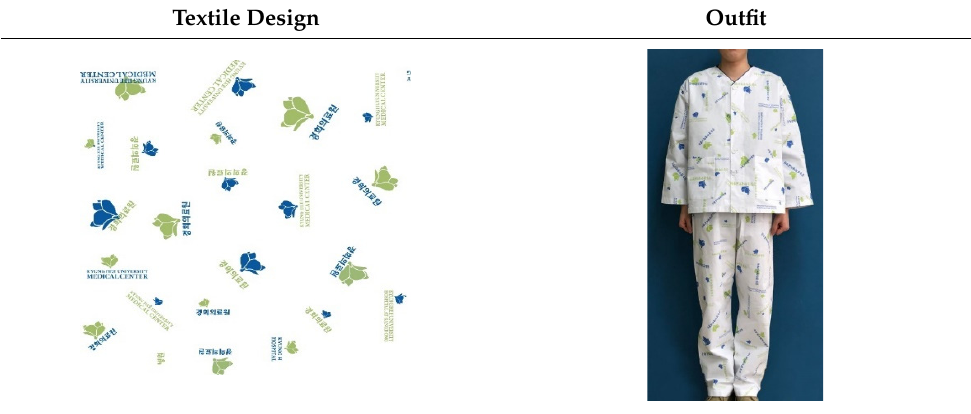
Table 1. Current patient clothing . Textile Design